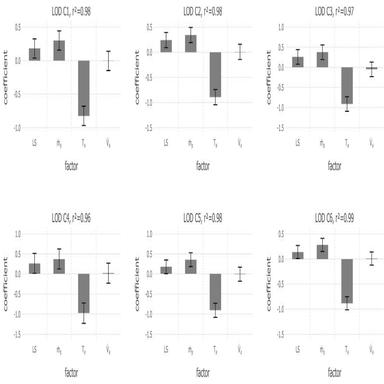
Coefficient plots of the MLR models obtained for LOD. The r 2 value is provided in the title; the 95% confidence intervals are given in the Figures.